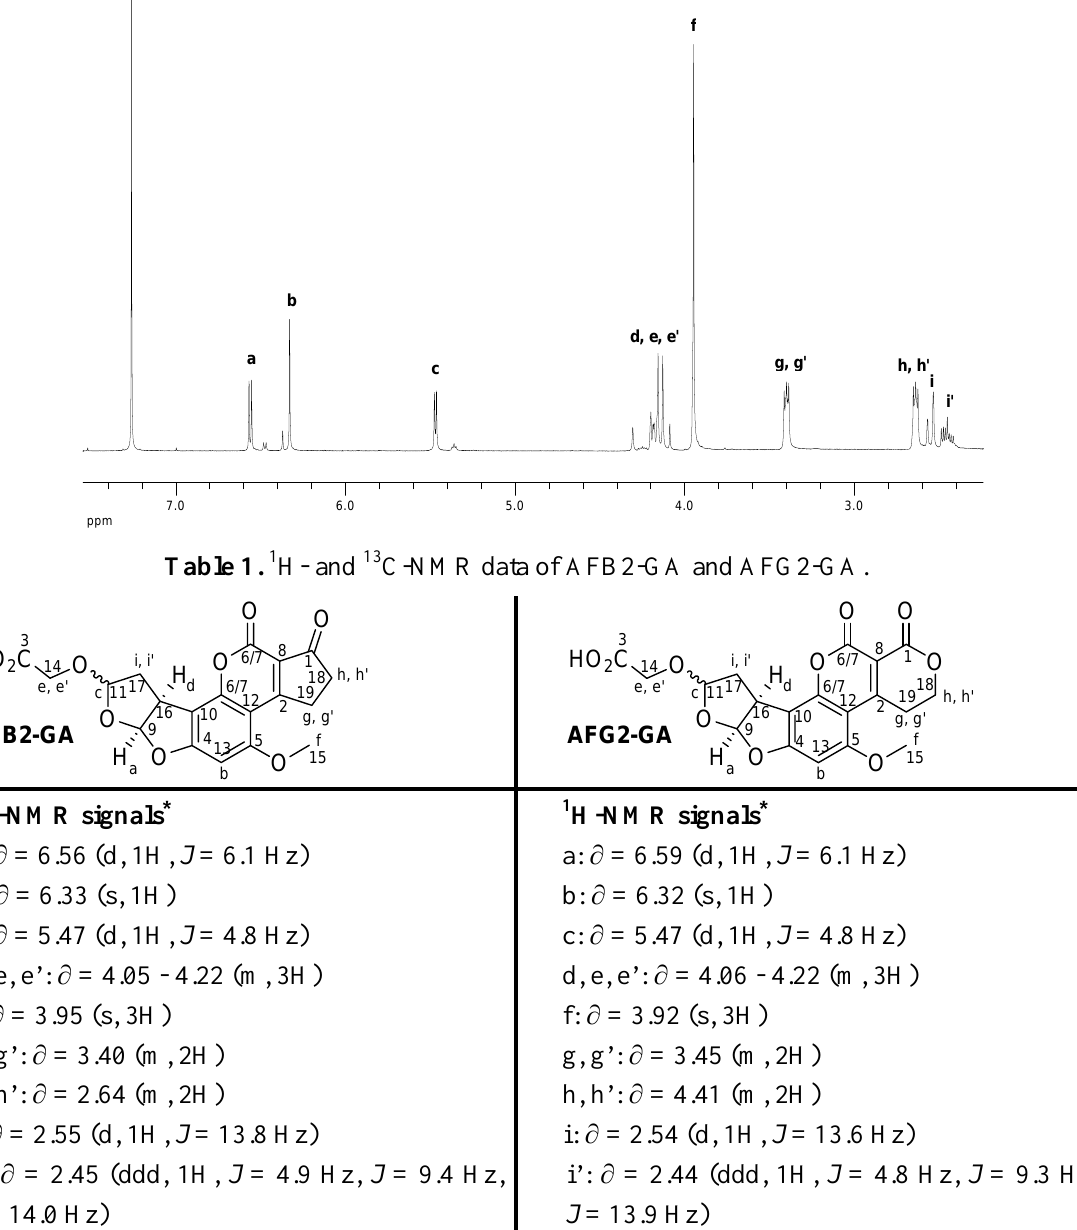
Figure 5. 1 H-NMR spectrum of AFB2-GA in CDCl